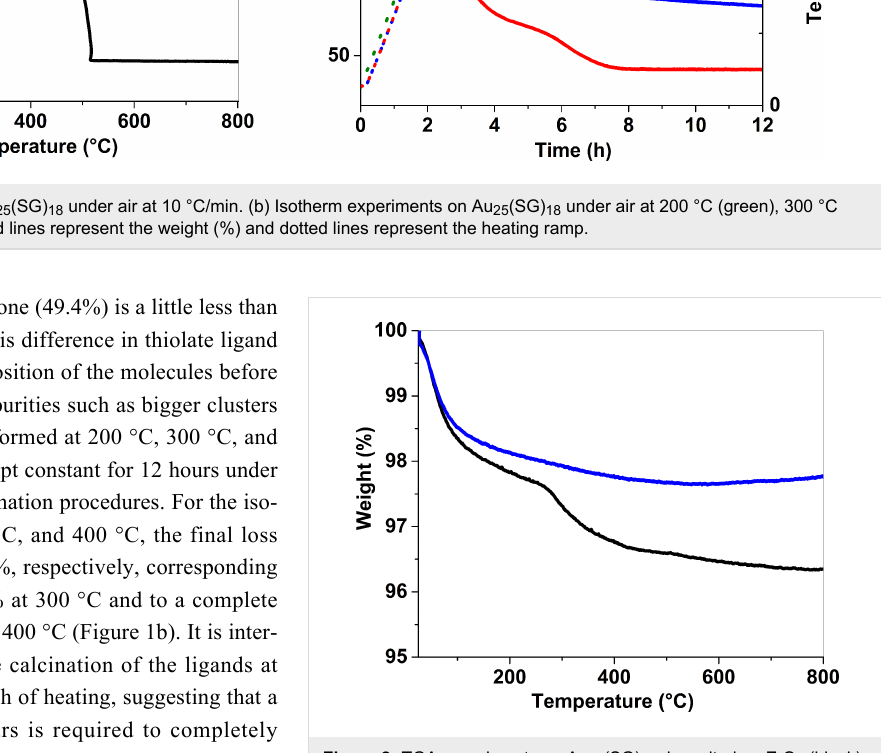
Au 25 gold cores (Figure 3d,e). In general, supported gold